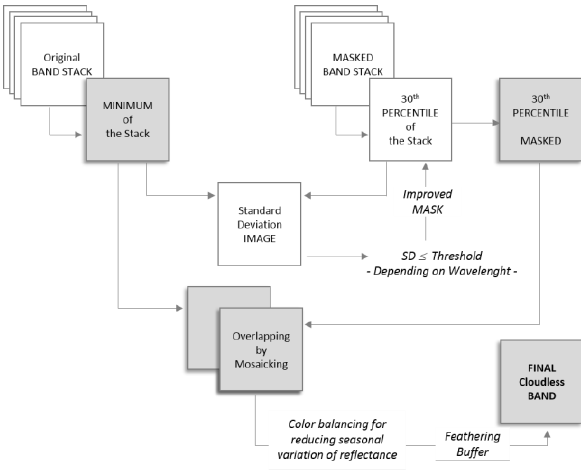
Figure 6. Workflow of the M2CTool reconstruction process